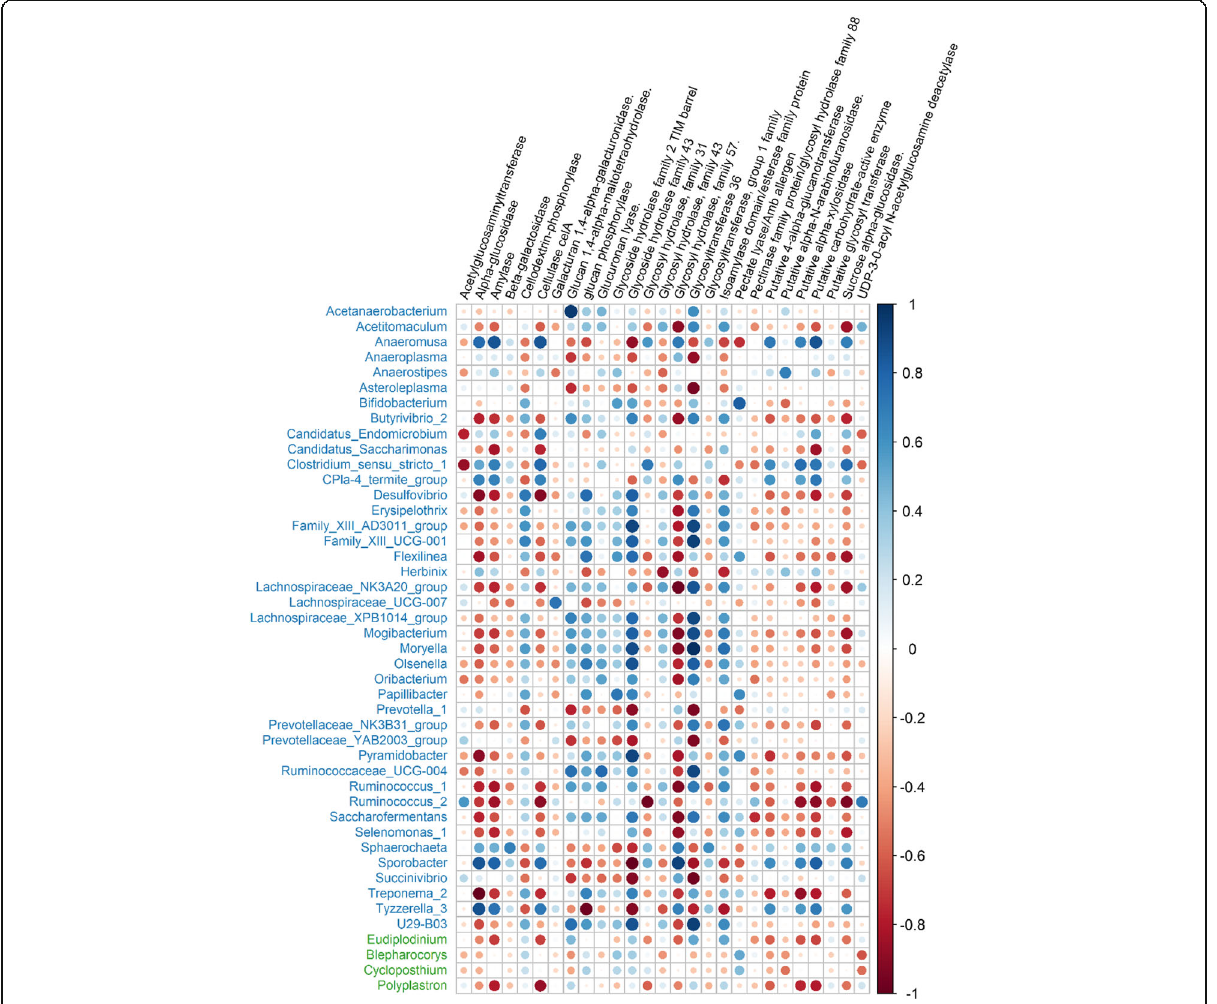
Fig. 7 Pairwise correlations between microbial genera and carbohydrate-active degrading enzymes. Only the enzyme expressions that were significantly correlated with bacterial genera were shown ( P value < 0.05, |r| > 0.5). The bacterial genera were colored by blue, and protozoan genera were colored by